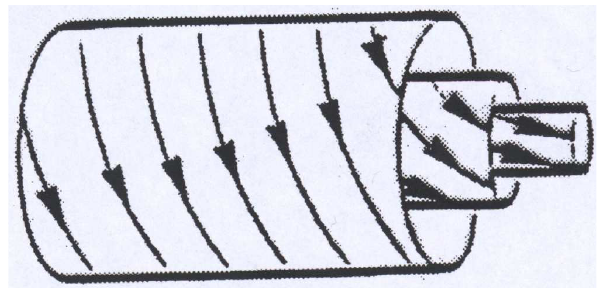
Fig. 1. The flux rope of type SWN showing the rotation of the magnetic field vector from the south to the west at the MC-axis and finally to the north at the trailing edge of the MC (Bothmer and Rust,